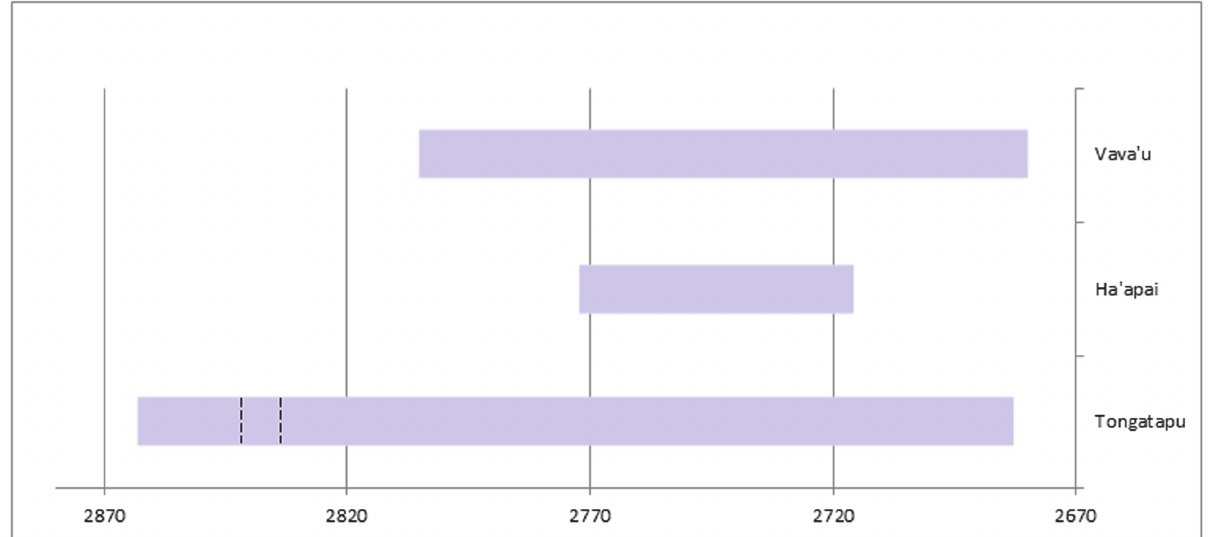
Fig 5. Modeled timelines for Lapita phase settlement in Tonga. Boundary ranges are the earliest and lates possible start/end date for Lapita for each group in the overlap model at 68.2% probability. The ranges are 2863 – 2683 cal BP for Tongatapu, 2772 – 2716 cal BP for Ha ʻ apai and 2805 – 2680 cal BP for Vava ʻ u. The dashed segment plots U/Th 11 – 36 (2838 ± 8 cal BP, 95.4%), a date relating to the founder event for human settlement